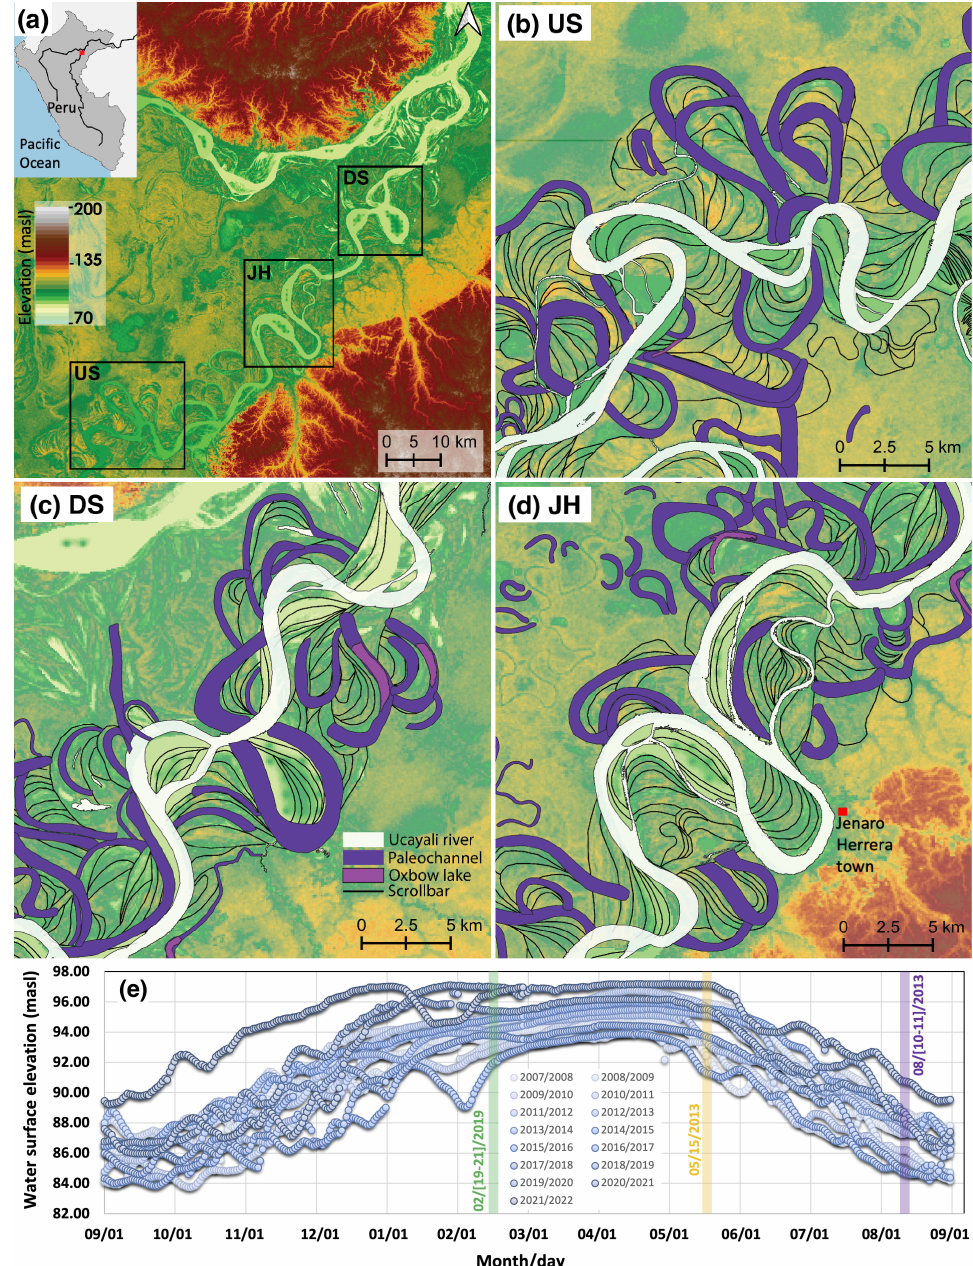
Figure 1. ( a ) The Ucamara depression (see the DEM) where the Ucayali River (meandering) meets the Marañón River (anabranching) to form the Amazon River (anabranching); ( b ) upstream (US) bend; ( c ) downstream (DS) bend; ( d ) the Jenaro Herrera (JH) bend along the Ucayali River. In ( b – d ) the main channel of the Ucayali River is shown as well as the reconstruction of paleochannels and oxbow lakes, describing the planimetric dynamic of the Ucayali River throughout time. For dynamics on the confluence between the Ucayali and Marañón Rivers, see [26], ( e ): the water surface elevation (m) at the Jenaro Herrera gauging station from 2007 to 2021. Shaded regions denote the field measurement campaigns in May and August 2013 and February